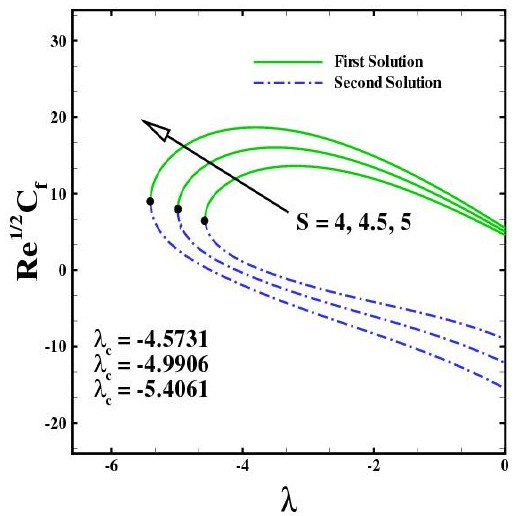
Figure 3. Influence of Re − 1/2 C_f with λ for various values of S and β = We = 0.3, n = 2, M = Ec = 0.5, A = B = 0.1, and Pr = 3.